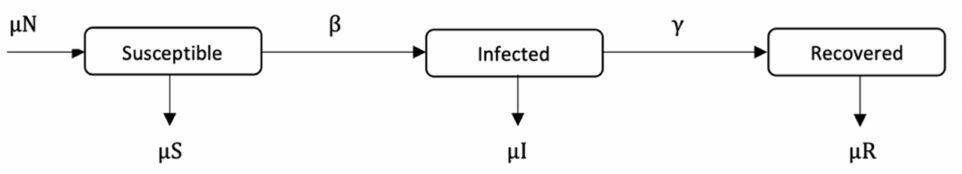
Figure 1. General outline of SIR